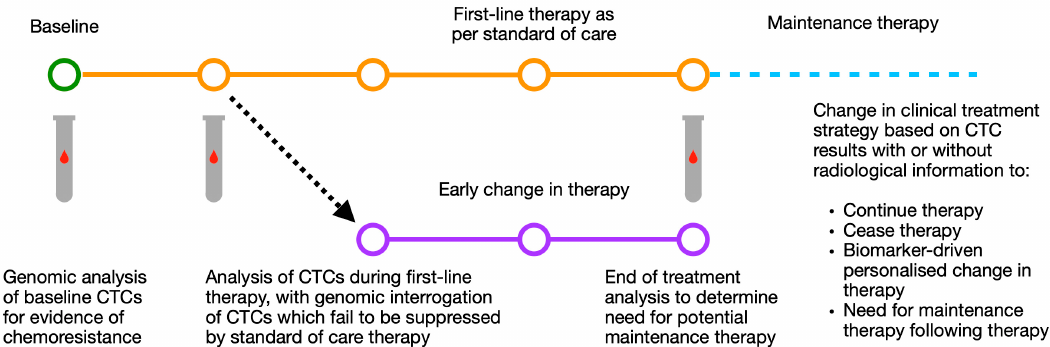
Figure 3. Schematic of possible routes for CTC based modification of individualised treatment strategy using baseline and mid-treatment CTC results by number and genomic analysis. CTC: circulating tumour cell.